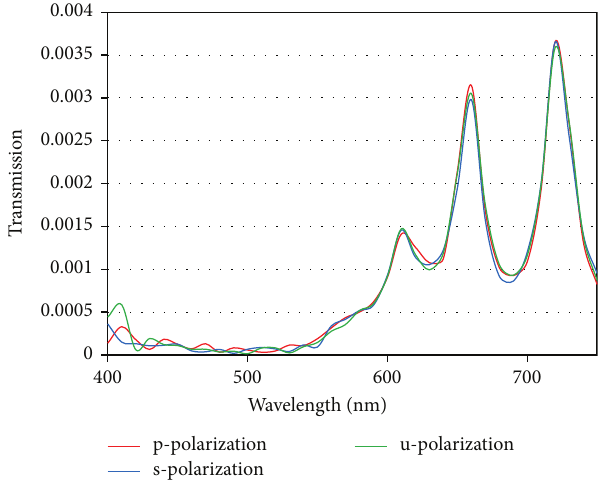
Figure 4: Transmission through the fishnet